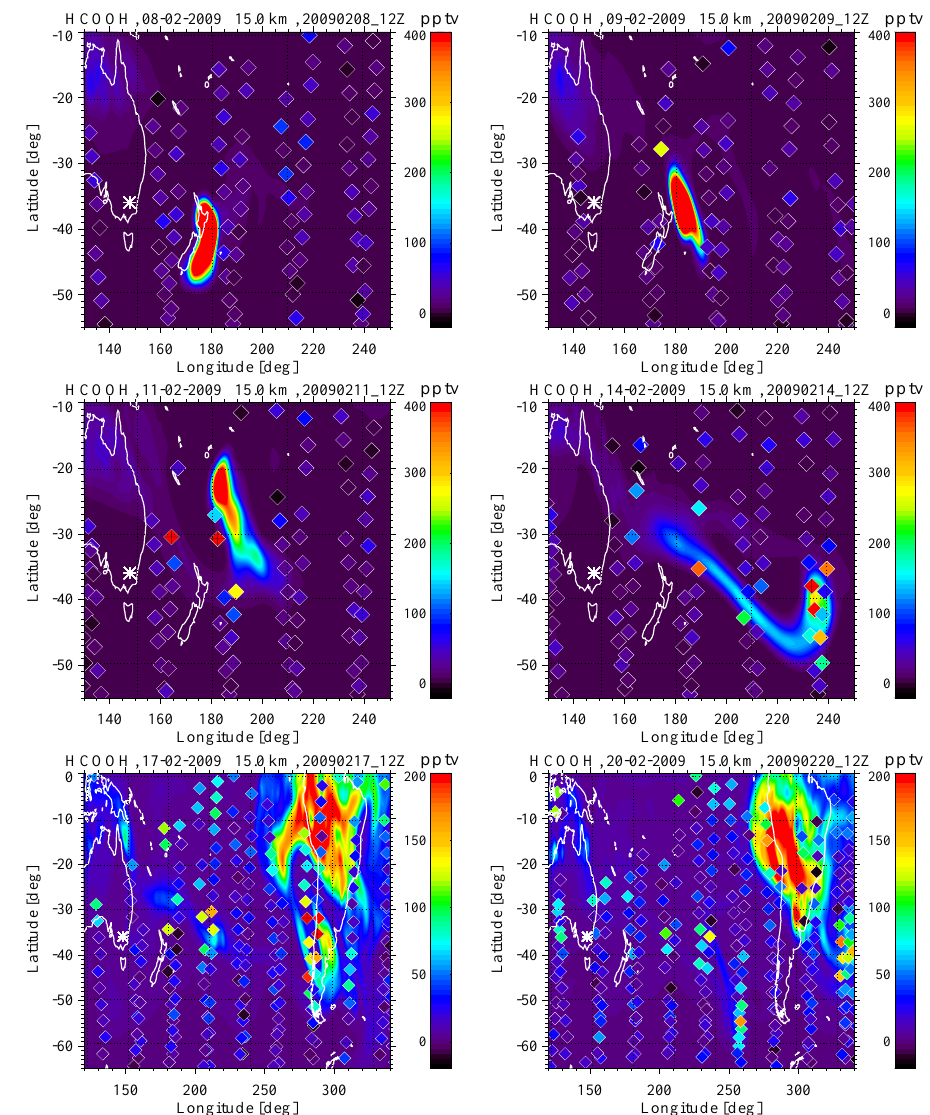
Fig. 5. Measured and modelled HCOOH at 15km altitude. Model distributions are smoothed vertically and along-track to MIPAS resolution. Note the different map section and colour scale for the bottom panel. For more details see Fig.